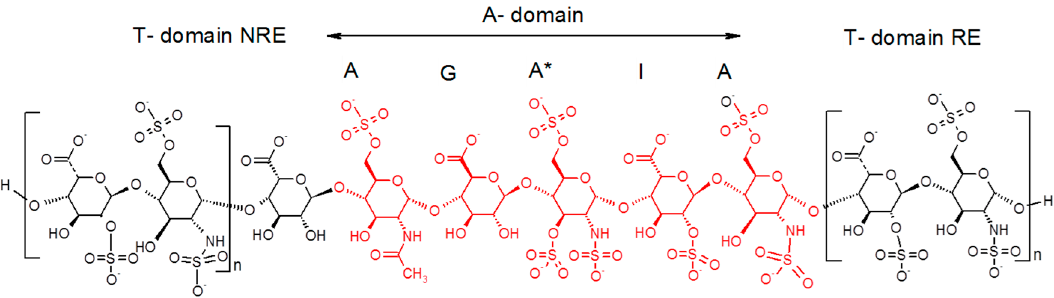
Figure 7. Model described for heparin oligosaccharides with Is disaccharide T domain extensions at reducing end (RE) and non-reducing end (NRE). Table 5. aFXa and aFIIa activities of isolated octadecasaccharides.